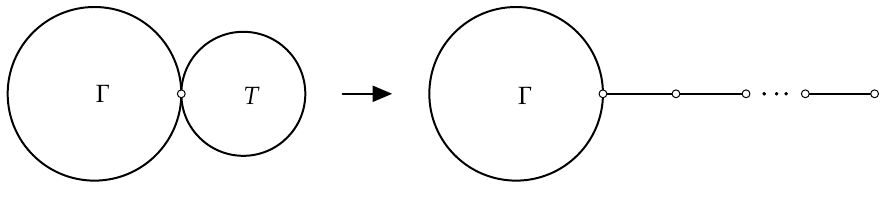
Figure 4. Repeating Transformation D